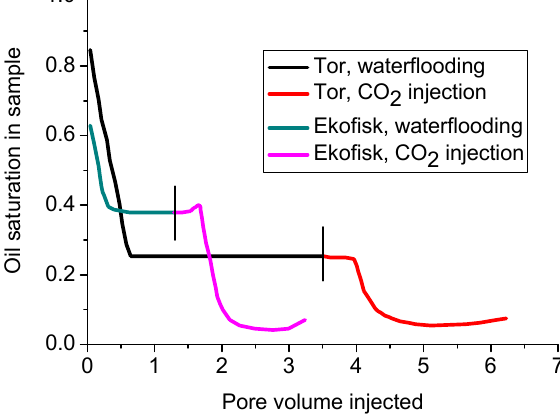
Figure 18 . Comparison of oil extraction using water flooding and CO 2 injection from the Tor and Ekofisk formations [56].